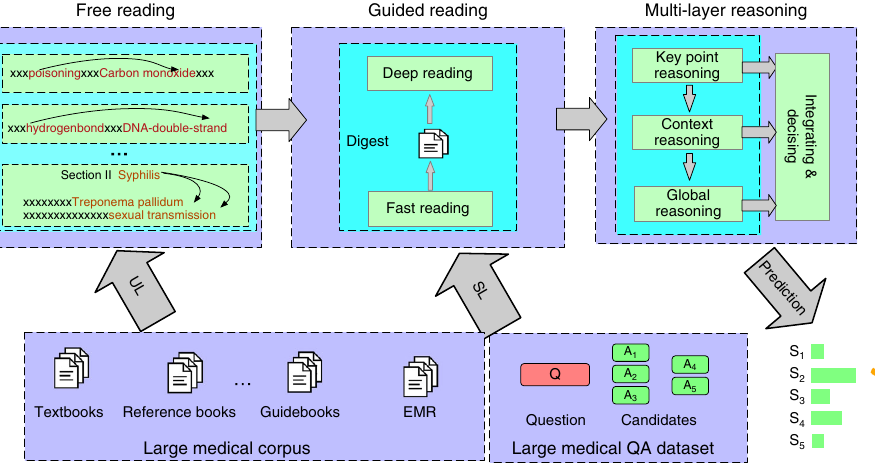
Fig. 5 Architecture of our proposed deep learning framework Med3R. Med3R is consists of three modules: Free R eading, Guided R eading, and Multi-layer R easoning. Firstly, primary medical knowledge is coarsely captured from medical text via the “ Free Reading ” module which is trained over large medical corpus with Unsupervised Learning (UL) methods. Then, Supervised Learning (SL) methods are conducted in the “ Guided Reading ” module where a “ Fast Reading ” strategy is fi rst used to collect a small digest (strongly related with given medical questions) from large medical corpus, then “ Deep Reading ” strategies are employed to analyze the digest and the given medical questions in deep manners. In the Reasoning phase, the “ Multi-layer Reasoning ” module is used to produce robust decision-makings by integrating reasoning at key-points level ( “ KeyPoint Reasoning ” ), sentence-context level ( “ Context Reasoning ” ) and global-digest level ( “ Global Reasoning ” ), respectively